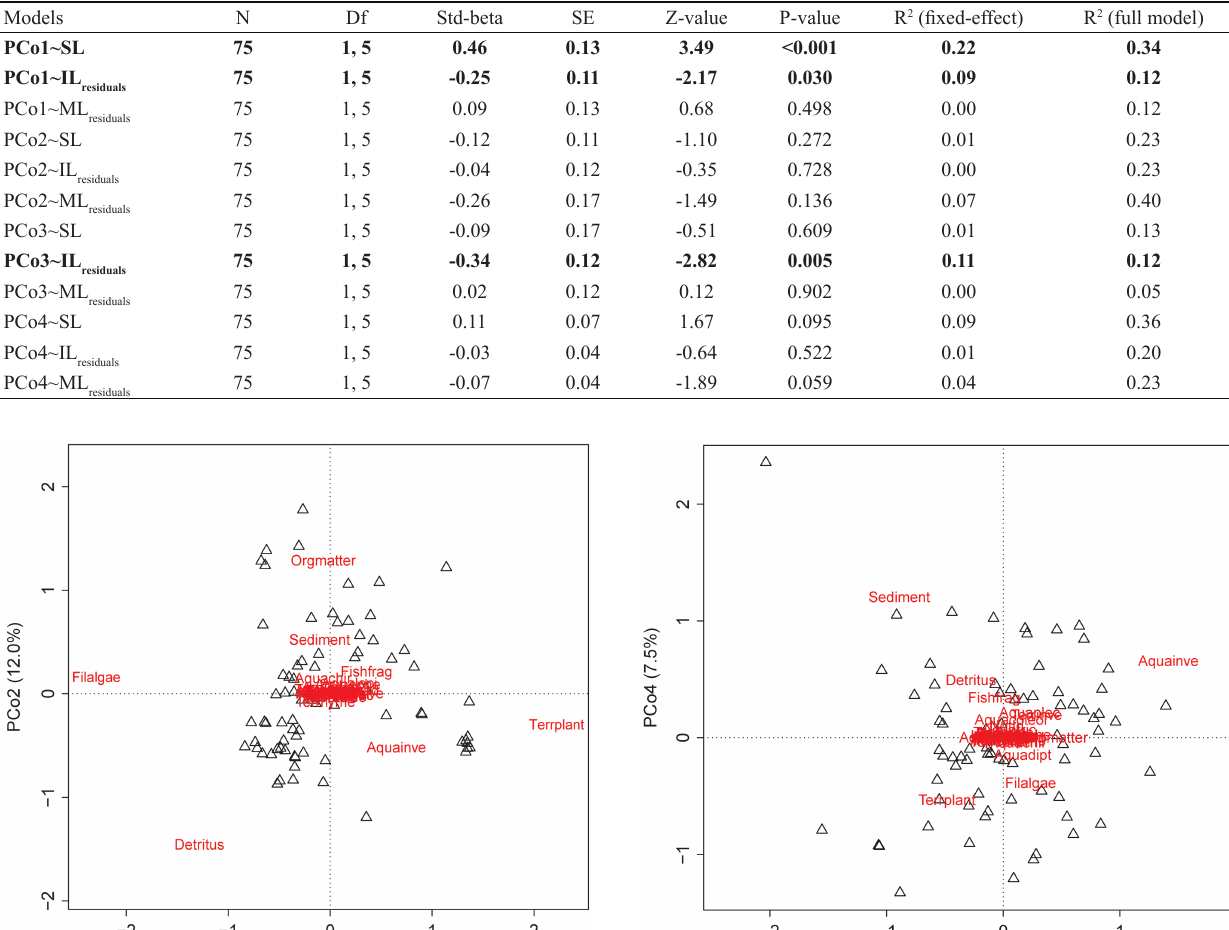
Table 3. Twelve models fitted with linear mixed-effects modeling to predict diet variation (PCo1, PCo2, PCo3 and PCo4) of Deuterodon stigmaturus individuals based on morphological traits (fixed effect variables). Sampling months were used as random effect variable to control for temporal effects on diet variation. N = number of individuals; Df = degrees of freedom; Std-beta = Standardized beta coefficient (effect size); SE = Standard Error; Z-value = standard score or number of standard deviations the observation is above the mean; R 2 (fixed-effect) = variation explained exclusively by fixed effect variable; R 2 (full model) = variation explained by both fixed and random effect variables; P-value = model significance. Boldface highlights models with significant fixed-effect.